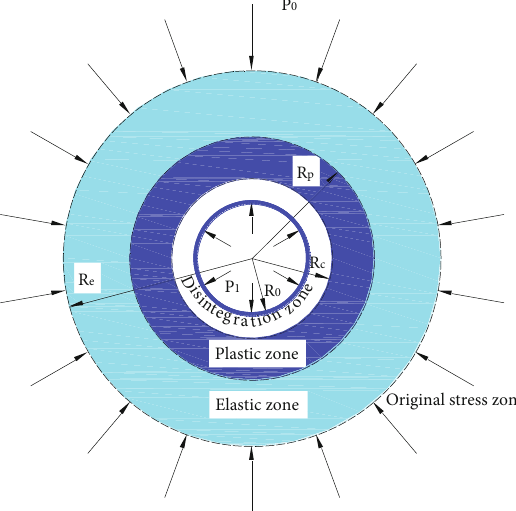
Figure 2: Mechanical model of circular